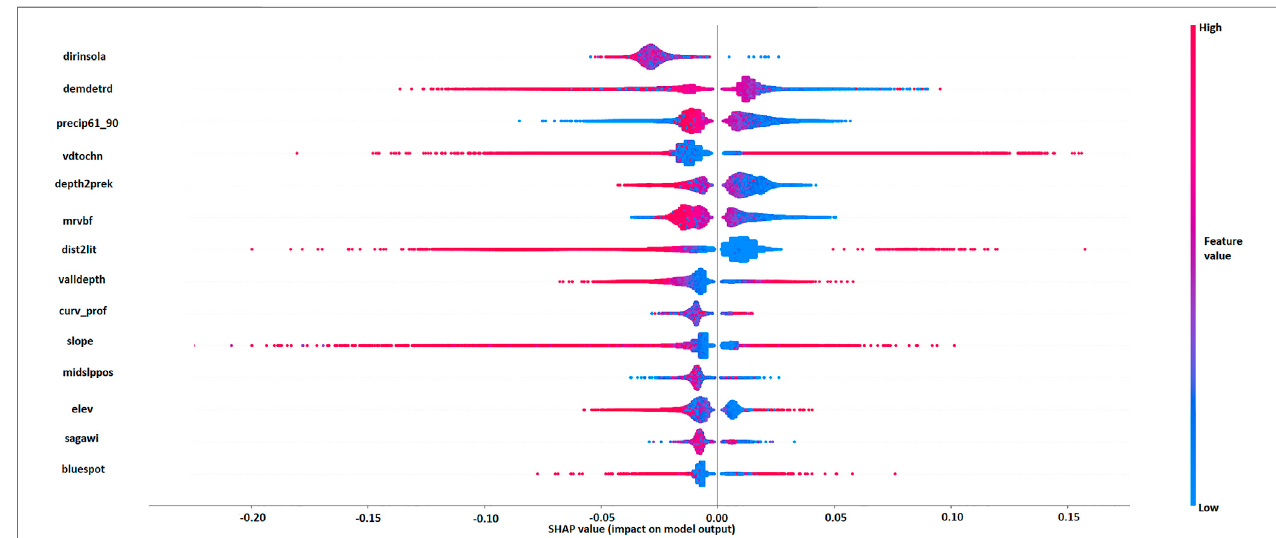
FIGURE 8 | Summary plot for the selected CNN model (clari fi cation of covariate/feature names in Table 1 ).